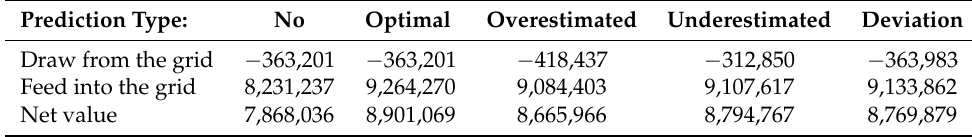
Table 9. Impact of forecast prediction on generation and feed-in in Wh for the different scenarios Prediction Type: No Optimal Overestimated Underestimated Deviation Draw from the grid −